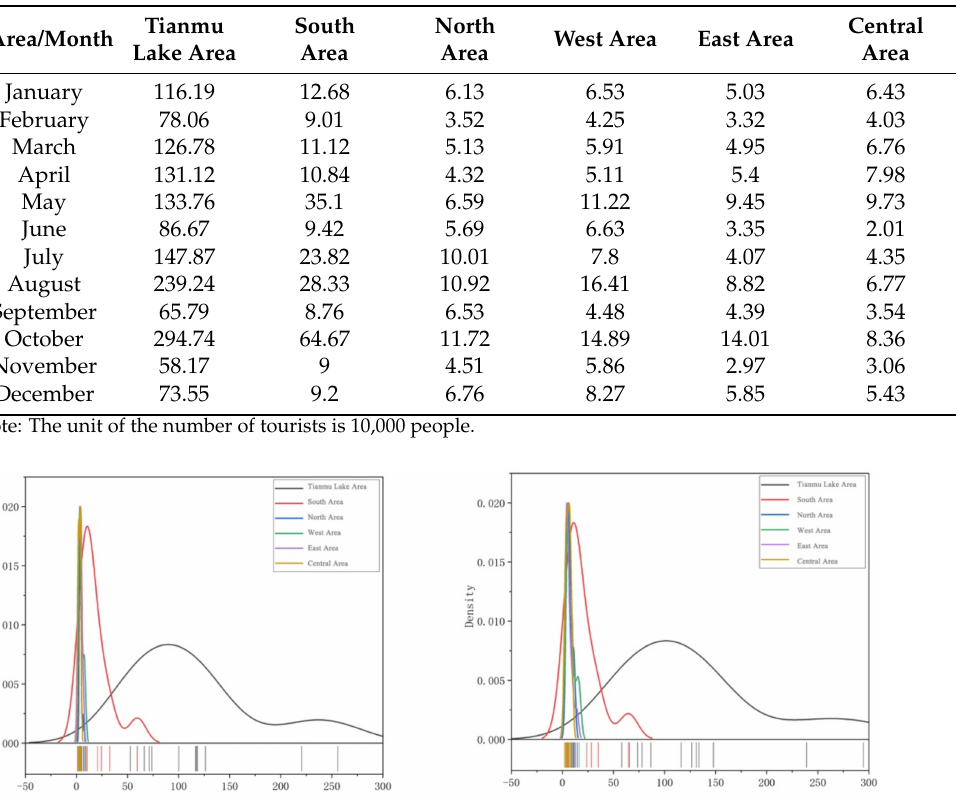
Table 9. List of numbers of tourists by month in each area of Liyang, 2019.